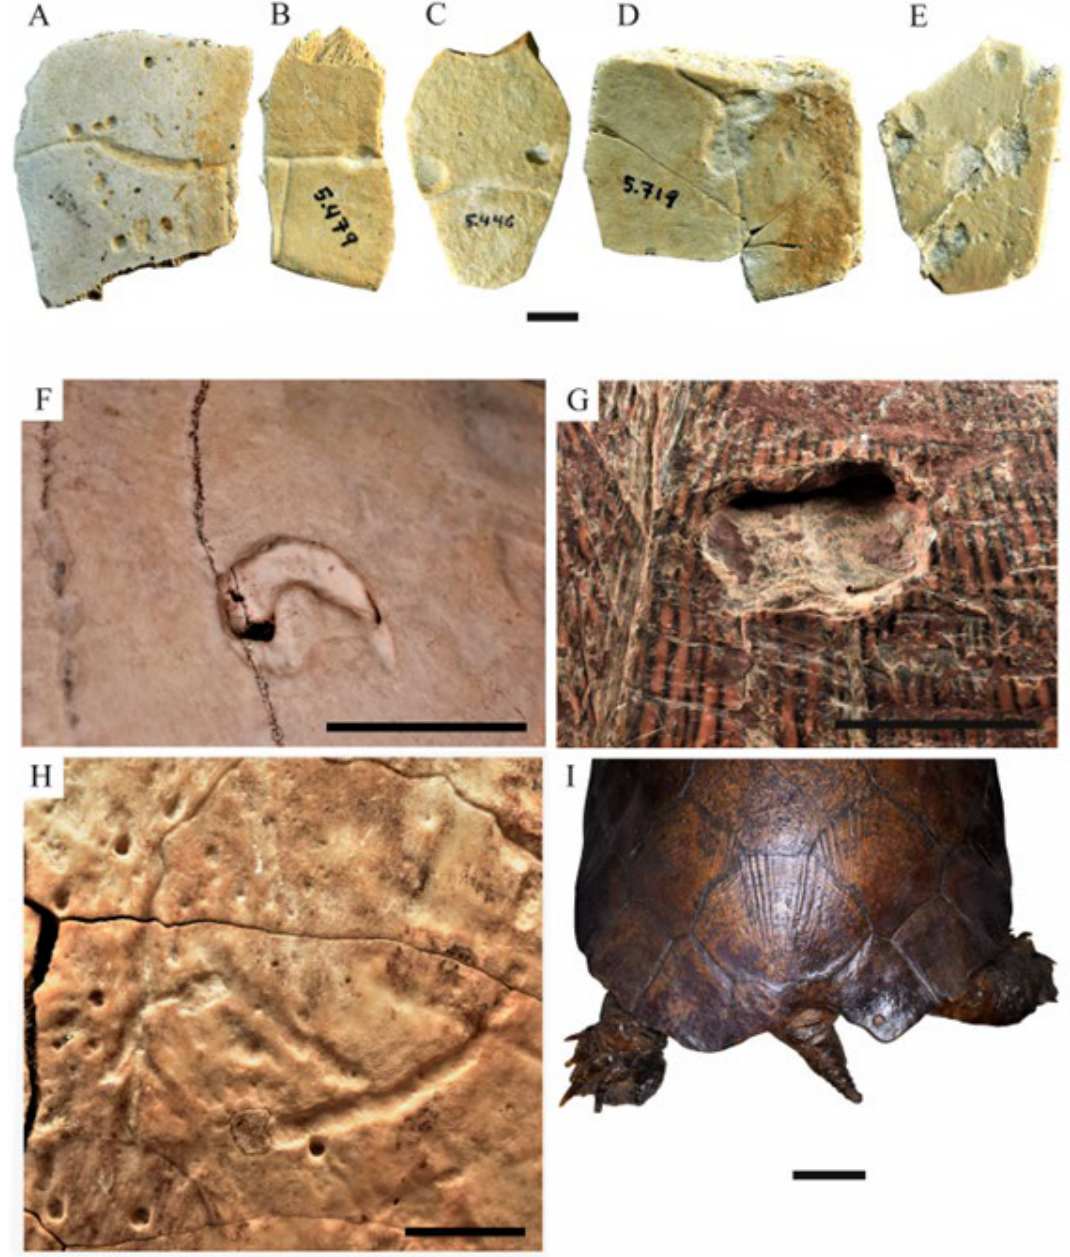
Figure 4. ( A – E ), Anomalous shell plates of the Spanish podocnemidid turtle genera Neochelys . ( A ) STUS 1502, ventral view of an hypoplastron of Neochelys sp. From La Laguna—Casaseca de Campeán (Zamora); ( B ) STUS 5479, dorsal view of a peripheral plate of Neochelys sp. From La La- guna—Casaseca de Campeán (Zamora); ( C ) STUS 5446, dorsal view of a neural of Neochelys sp. From La Laguna—Casaseca de Campeán (Zamora); ( D ) STUS 5719, dorsal view of a peripheral plate of Neochelys sp. From La Laguna—Casaseca de Campeán (Zamora); ( E ) STUS 8255, ventral view of a xiphiplastron of Neochelys salmanticensis from Cabrerizos (Salamanca). ( F – I ) Erymnochelys madagas- cariensis specimens (Pleurodira, Podocnemididae), of the Muséum national d’Histoire naturelle (Pa- rís, France), with similar anomalies to those of STUS 14024. F, MNHN.ZA.AC 1897-80; ( G ) MNHN.ZA.AC 1946-71; H, MNHN.ZA.AC 1923-430; I, MNHN.RA To.0609-2. Scale bars equal 1 cm in ( A – E ), and 2 cm in ( F – I